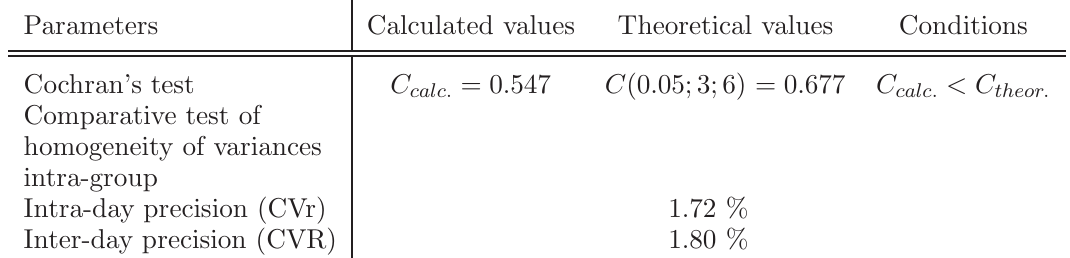
Table 4 Cathodic differential pulse voltammetric calibration curve parameters for colchicine using the three different types of